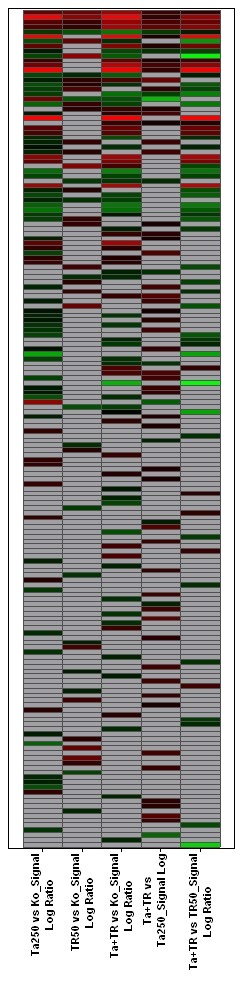
Overall expression patterns of 174 reliably measured probe sets associated with apoptosis out 621 apoptosis associated probe sets of the HG-U133A_2.0 chip. Horizontal rows represent individual probe sets/genes; vertical columns represent individual samples (from left to right: Colour range: Brightest red: Signal Log Ratio (SLR) >= 2 (indicates expression level above compared sample); brightest green: SLR <= 2 (indicates expression level below compared sample); black: SLR = 0 (indicates unchanged expression); grey: no reliable filter target.